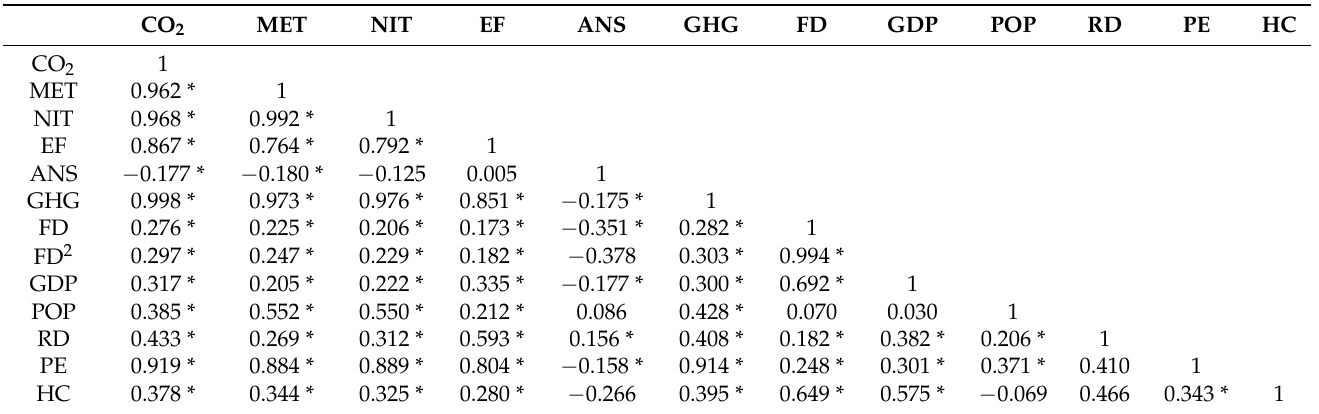
Table 4. Pairwise